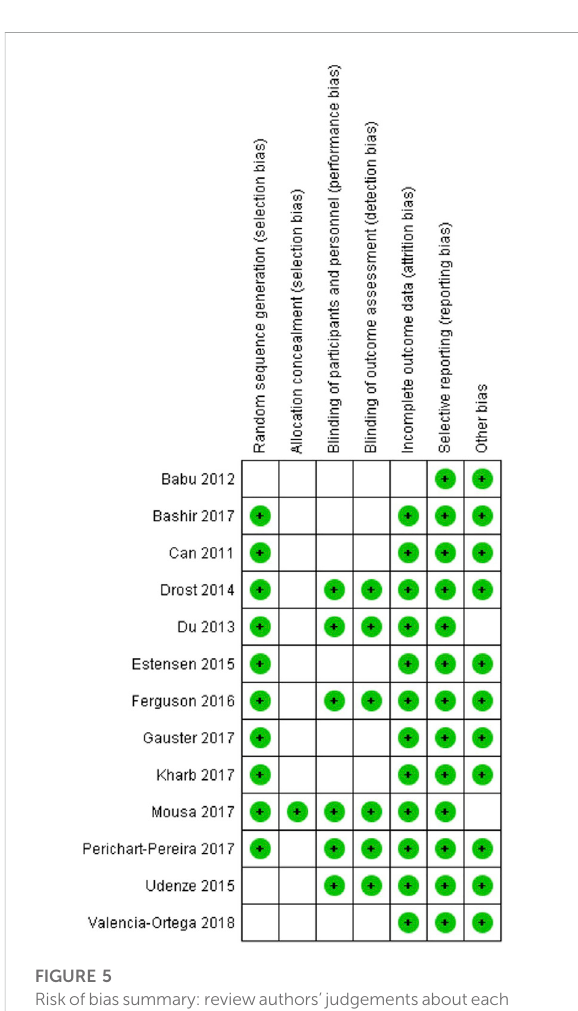
FIGURE 5 Riskofbiassummary:reviewauthors ’ judgementsabouteach risk of bias item for each included